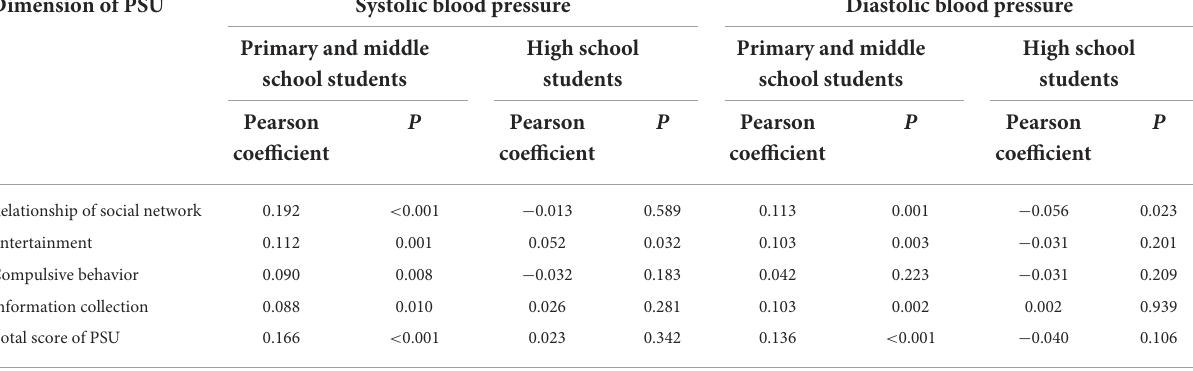
TABLE 2 Differences of the associations between four separated dimensions of PSU and blood pressure by grade of students. Dimension of PSU